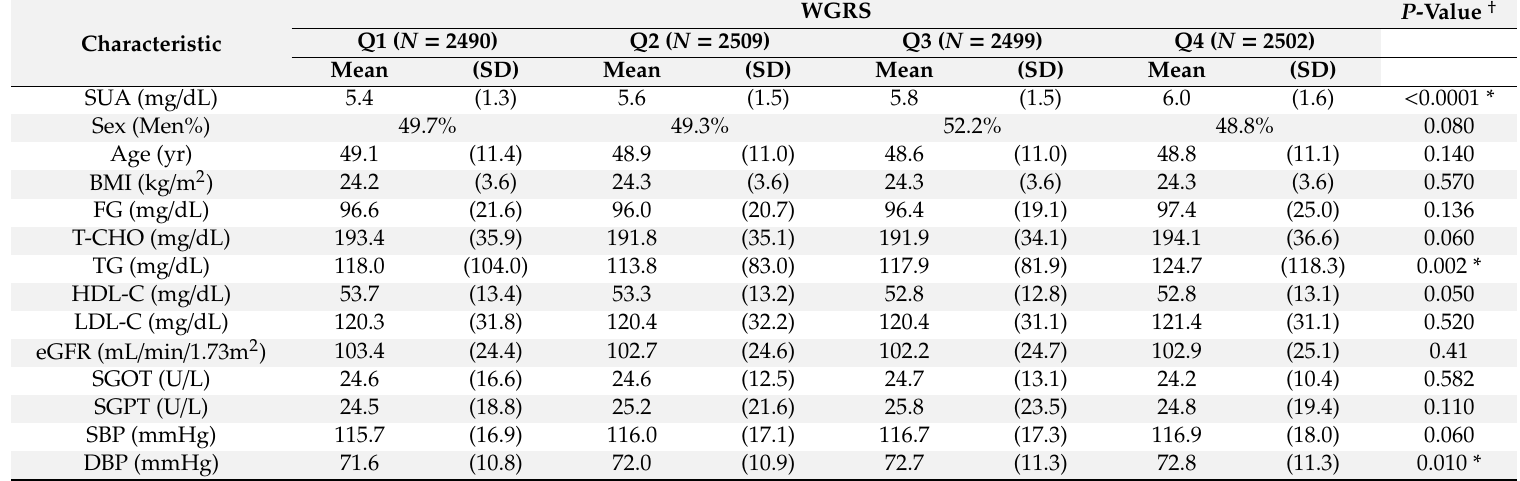
Table 2. Sample characteristics by weighted genetic risk score (WGRS)